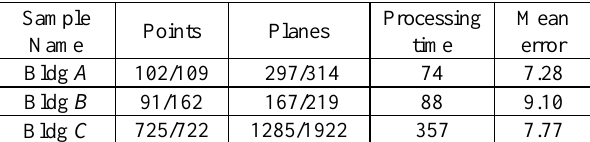
Table 4. Evaluation of the results. Number of points [x10 4 ] and extracted planes, processing time [sec], mean error of distance between correspondence planes